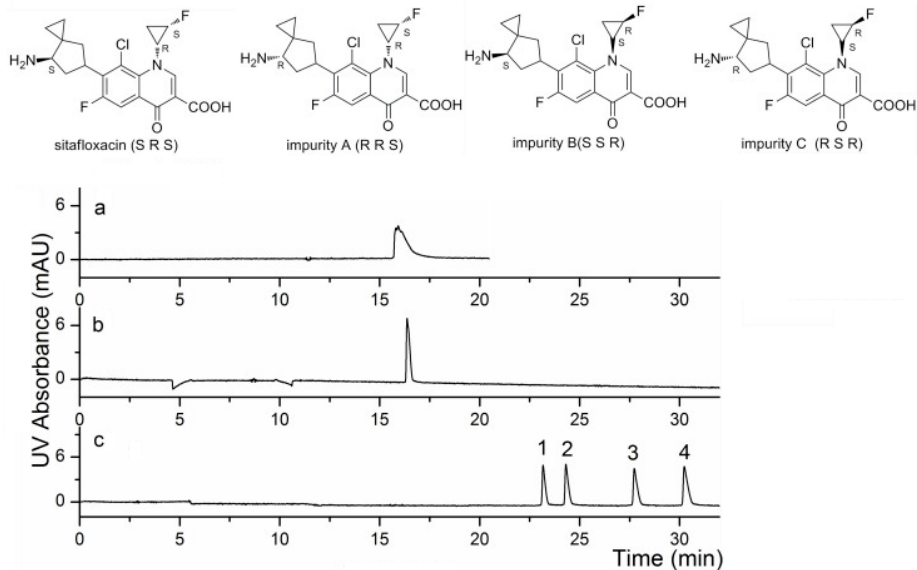
Figure 6. Electrochromatograms of sitafloxacin and its impurities under different separation conditions ( a – c ). Conditions: fused silica capillary, 60 cm (49.5 cm effective length) × 50 μ m